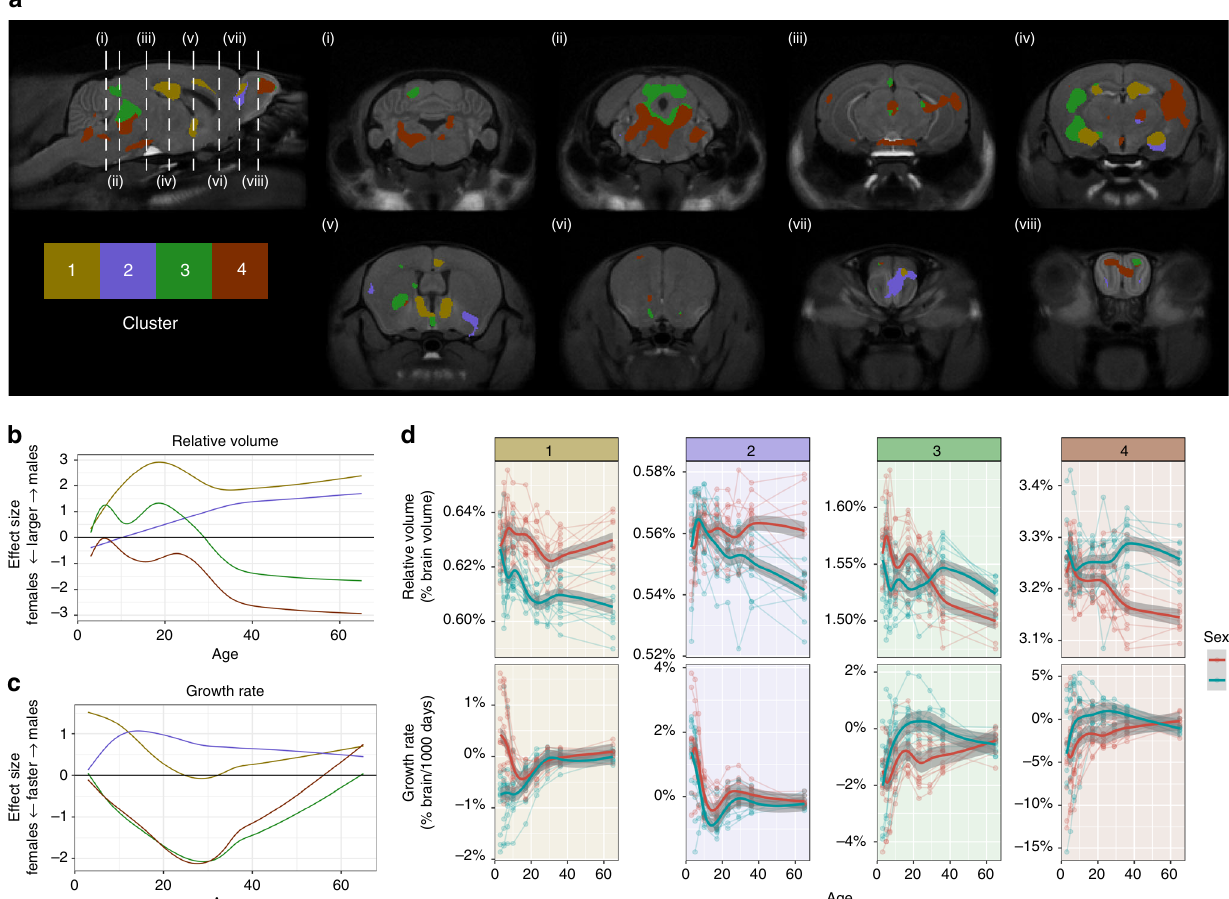
Fig. 6 Coordinated growth of sexually dimorphic functional networks. Sexually-dimorphic voxels with similar effect sizes through time were clustered into 4 groups using k -means. a Results of the clustering analysis on sexually dimorphic voxels. Effect sizes (positive is bigger in males, and negative is bigger in females) of b Relative volumes and c Growth rate for the different clusters. d Average volume and growth rate in each cluster for each individual. Cluster 1 corresponds to regions larger in males and this dimorphism emerges early in development. Regions involved in the vomeronasal system, which processes pheromonal information, are found in this cluster. Cluster 2 also contains regions larger in males but the onset is more delayed. However, this cluster in early life shows strong bias in growth rate towards males. Parts of this cluster include the olfactory bulb and pallidum. Cluster 3 voxels trajectory switches from being larger in males in early life, to larger in females post-puberty. Parts of the sensory cortex and PAG belong to this cluster. Cluster 4 contains regions that are not sexually dimorphic in early life but become relatively larger in females over the course of development. This cluster includes association related areas such as parts of the central thalamus and temporal association cortex; and motor related areas such as parts of the hindbrain, cerebellum, caudoputamen, and motor cortex. Both Cluster 3 and 4 show growth rate bias towards females peaking around